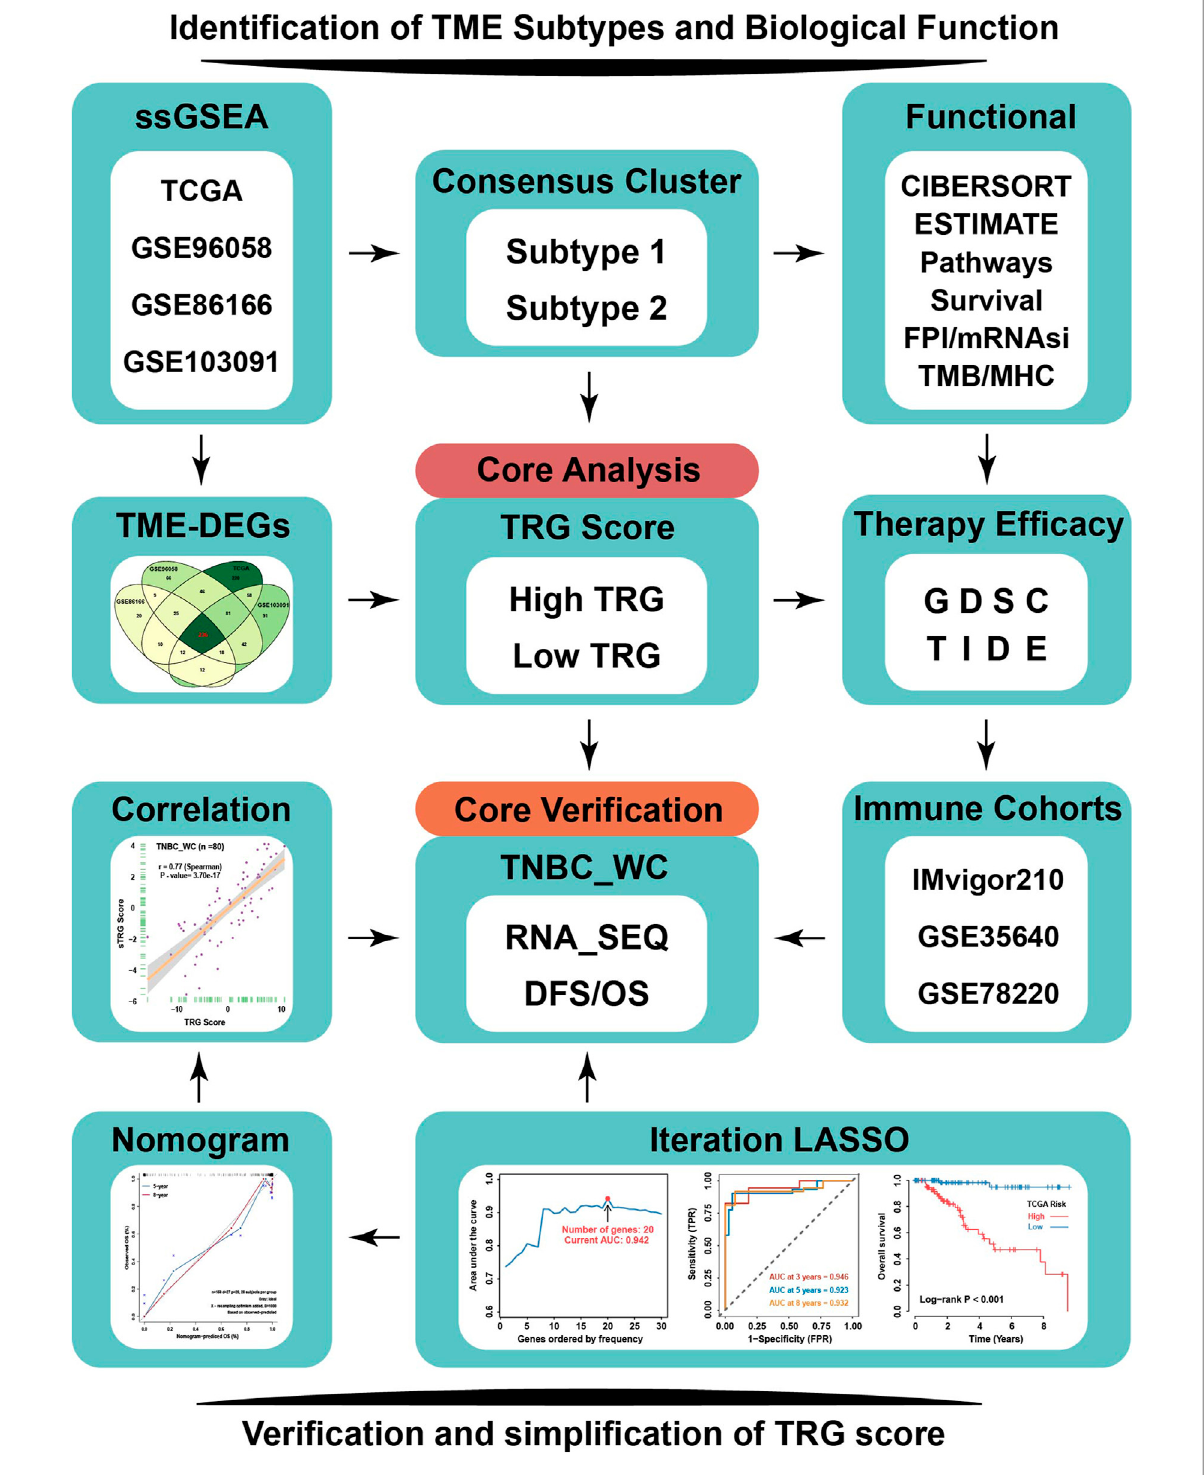
FIGURE 1 Flowchart of our research. TNBC patients from four independent TNBC cohorts (TCGA, GSE96058, GSE86166, and GSE103091) were used to conduct an unsupervised clustering analysis based on relative immune cell in fi ltration levels. Two TME subtypes were identi fi ed and systematically correlatedwithrepresentativetumorcharacteristics.TRGscorebasedonTME-relatedDEGscalculatedbymachinelearningwasemployedtore fl ect TME subtypes ’ attributes. TRG score could predict response to immunotherapy and sensitivity to multiple drugs in TNBC by TIDE and GDSC